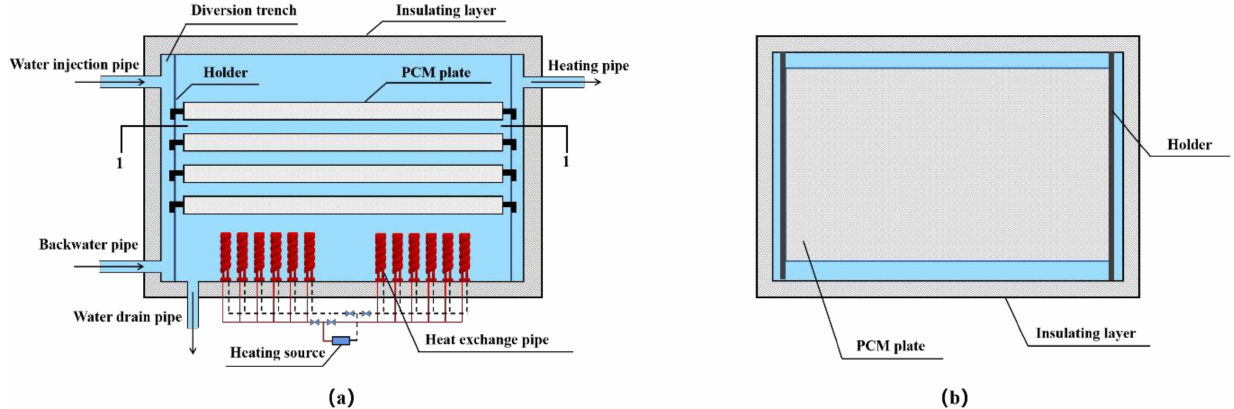
Figure 1. ( a ) Front view of the PCM storage tank; ( b ) 1-1 cross sectional of the PCM storage